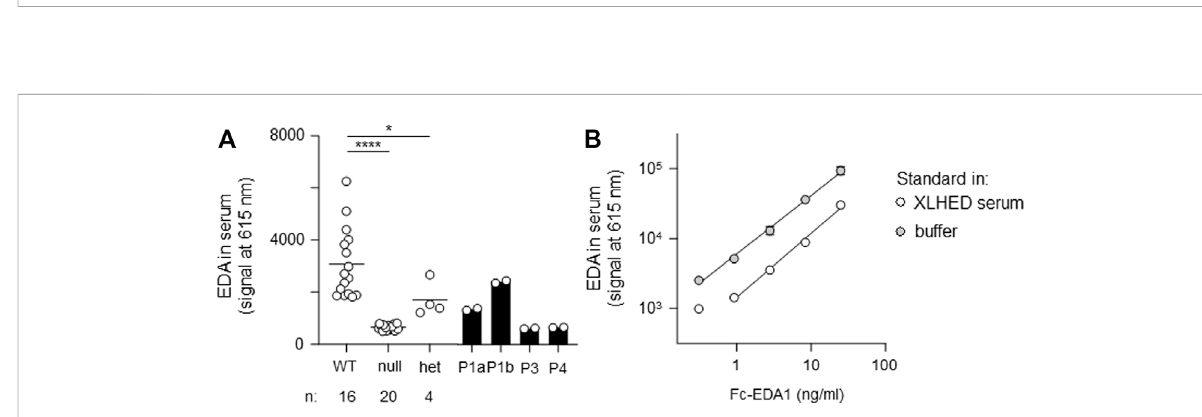
FIGURE 4 AlphaLISA measurements of circulating EDA in serum samples. (A) Probes were analyzed in duplicates. The average value is displayed for wild- type(WT, n =16),nullmutations(null, n =20),andheterozygousvariants(het, n =4).Individual values areshownforpatientsP1a, P1b,P3,andP4. (B) Recombinant Fc-EDA1 standard was measured at the indicated concentrations either in assay buffer or in serum of an XLHED individual with a null